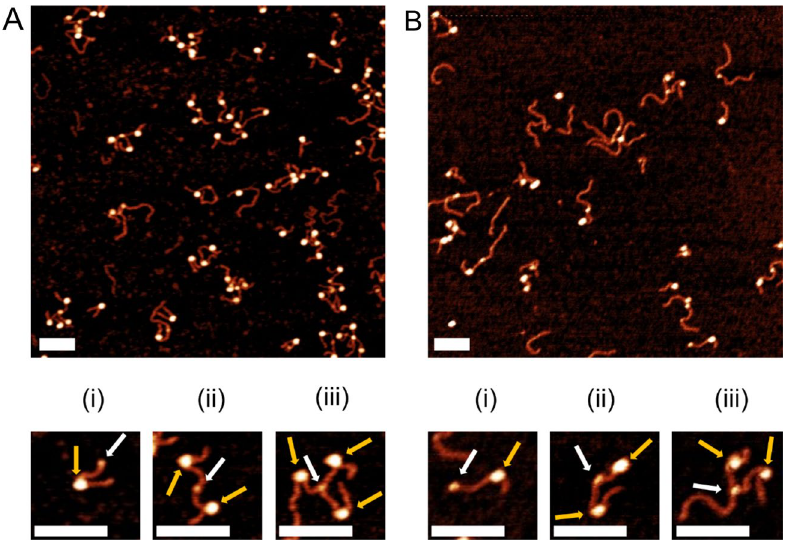
Figure 1. Representative images of mononucleosome samples with snapshots below. White arrows indicate streptavidin and gold arrows indicate the nucleosome core. Scale bars indicate 100 nm. (i), (ii), and (iii) show one, two, and three nucleosomes bound by streptavidin, respectively. ( A ) Nucleosomes assembled on 601 substrate. ( B ) Nucleosomes assembled on MS